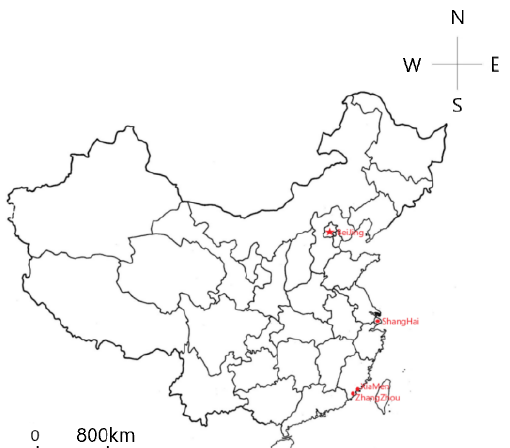
Figure 1. The locations of the three sampling sites in Shanghai, Xiamen, and Zhangzhou (denoted by the red squares).